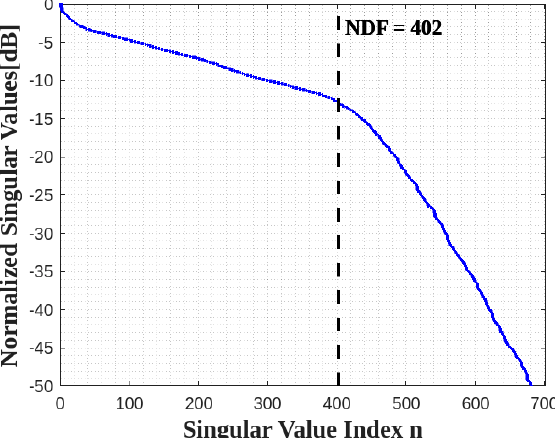
Figure 7. The geometry of the XY and XZ faces for an L-shaped ID.